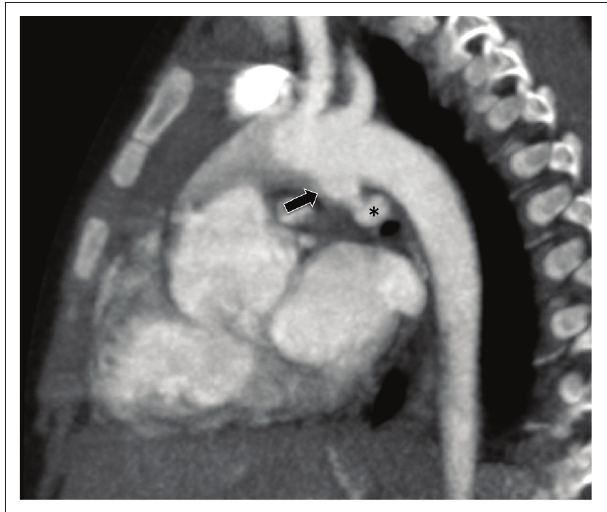
FIGURE 4: Sagittal oblique MIP in a 2-year-old boy with a PDA (arrow) reconstituting a small-calibre left pulmonary artery